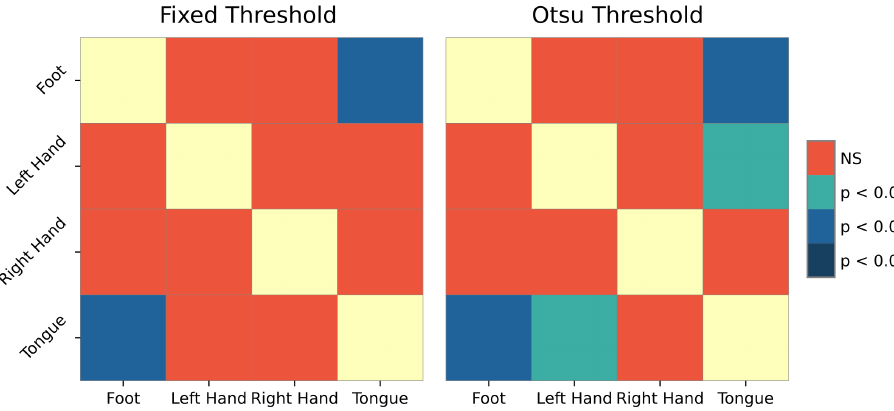
Figure 9. Post hoc test scores in k -core for Otsu’s threshold on window 3.5–5.5